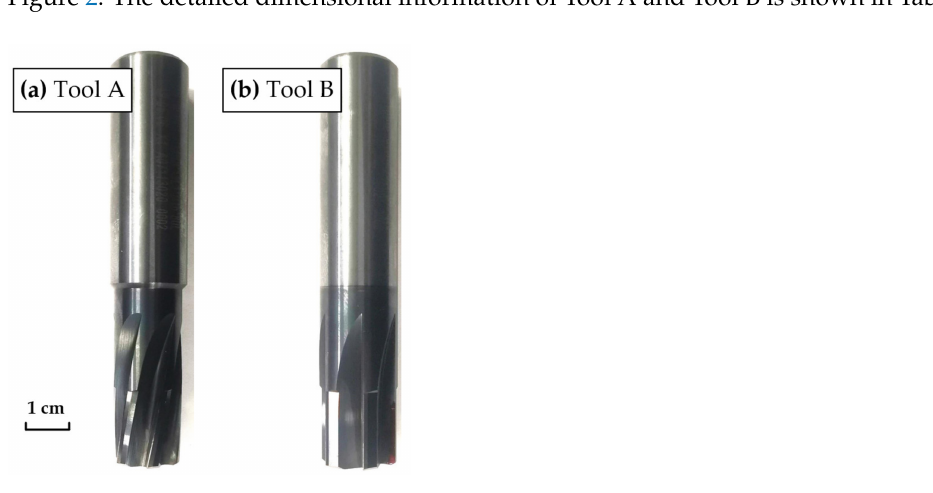
Figure 2. Cutting tools: ( a ) Right-hand reamer, marked as Tool A; ( b ) Straight groove reamer, marked as Tool B. Table 1. The dimensional information of Tool A and Tool B.